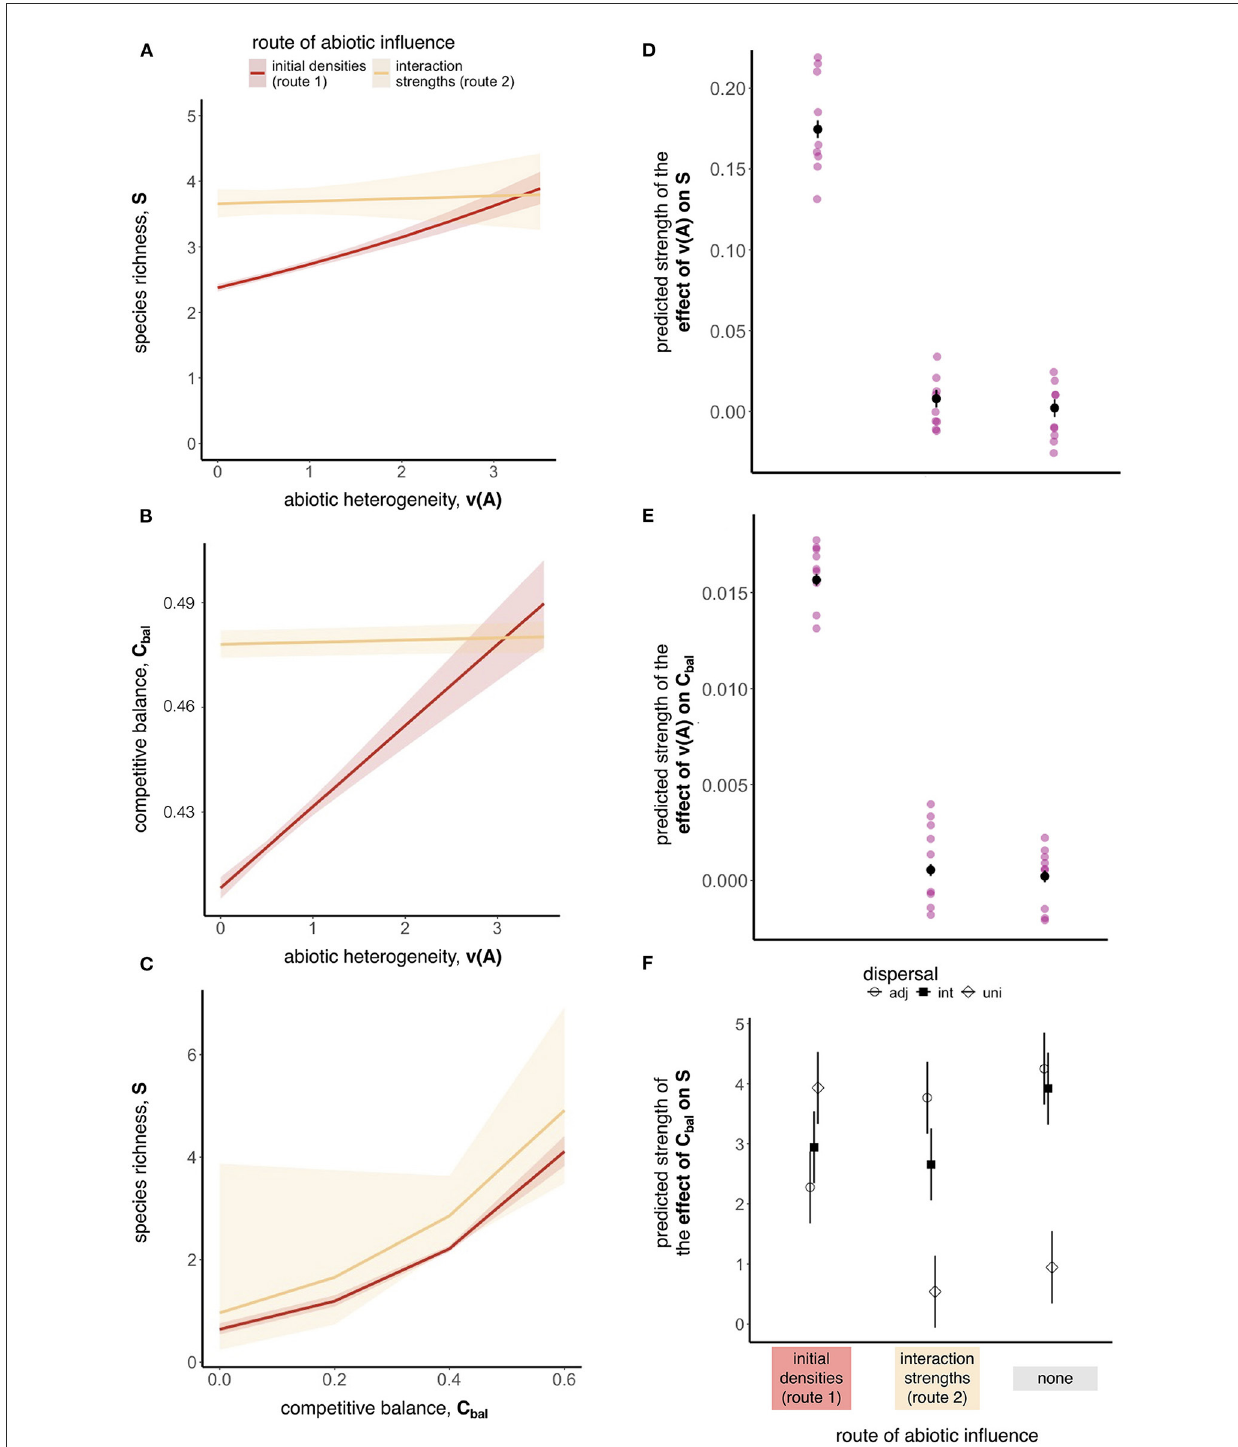
FIGURE5 Relationships between abiotic heterogeneity and species richness (row 1), abiotic heterogeneity and competitive balance (row 2), and competitive balance and species richness (row 3) when abiotic conditions influenced initial density during germination (route 1) or interaction strengths during competition (route 2). As an example, (A–C) show generalized linear mixed-effect model (glmer) predictions for simulations with intermediate dispersal and α ij = α ii . Shading around predicted values are 95% confidence intervals. (D–F) Capture average trends across parameter combinations (i.e., lighter data points in (D, E) are fixed effect coefficients from a glmer model, while the darker points and whiskers are estimated marginal means and 95% confidence intervals from the linear model). (D, E) Show the main effect of route of abiotic influence on predicted relationship strengths. (F) Shows the interaction effect of route of abiotic influence and dispersal on the fixed effect coefficients from the effect of competitive balance on species richness and for clarity shows only estimated marginal means and 95% confidence intervals. We decided not to plot the interaction effect in (D) because, although statistically significant, it explained less than 2% of the variation in relationship strength (Table 1). Predictions in (E) come from a linear model excluding an interaction (see Supplementary Section 1.4). All data were measured in small sampling units (5 x 5